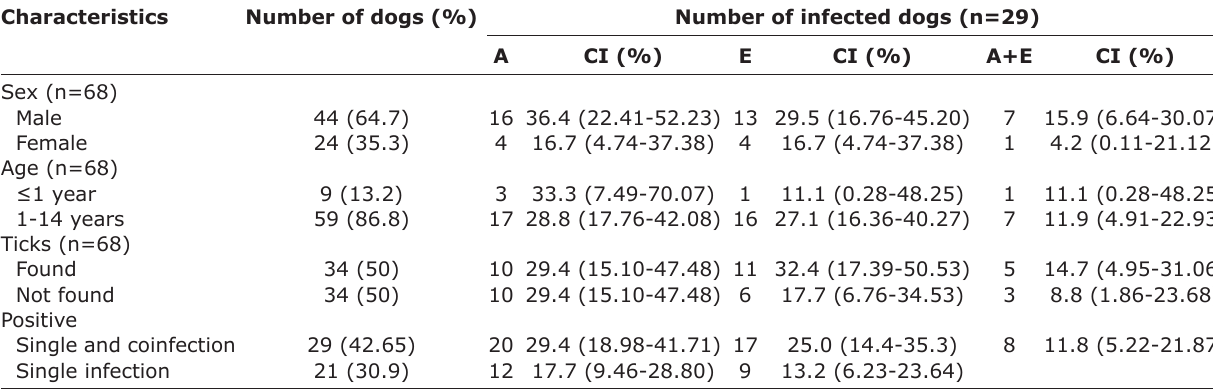
Table-1: Prevalence of A. platys and E. canis infections by demographic characteristics of dogs. Characteristics